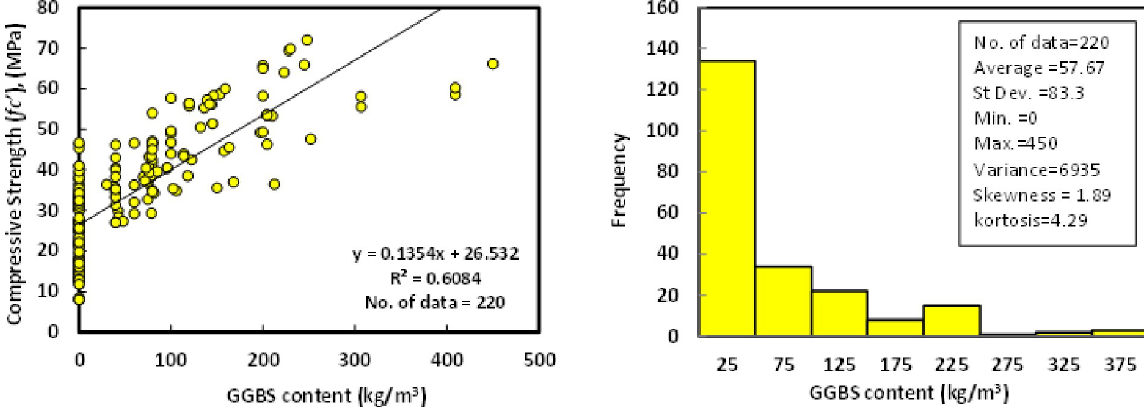
Fig 5. Relationship and a histogram of compression strength and curing temperature of GGBS/FA-GPC.